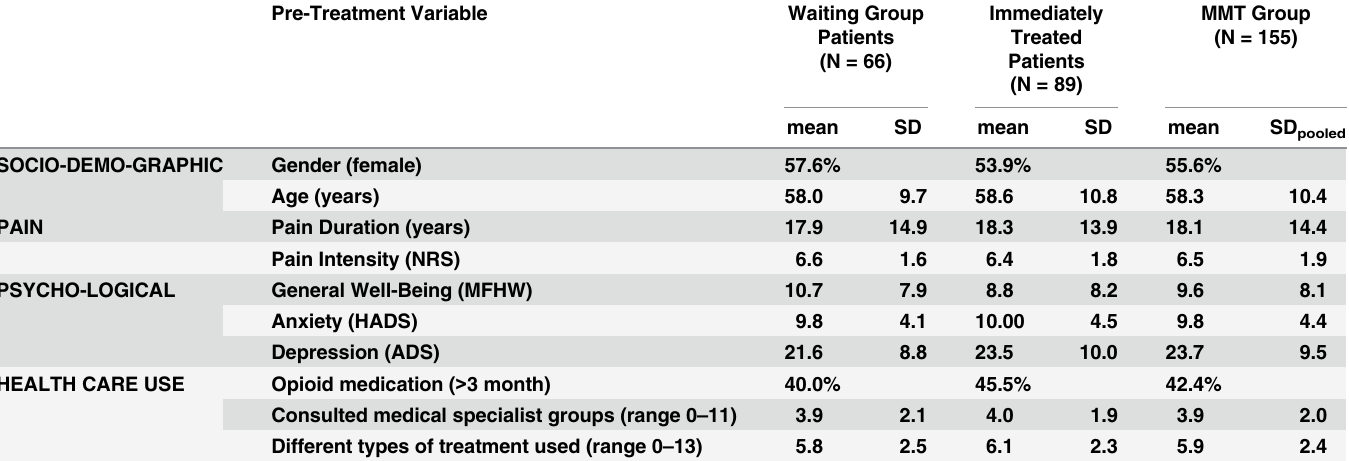
Table 1. Socio-demographic, pain-related, psychological and healthcare utilization measures for MMT group sample (waiting group patients and immediately-treated patients. Pre-Treatment Variable